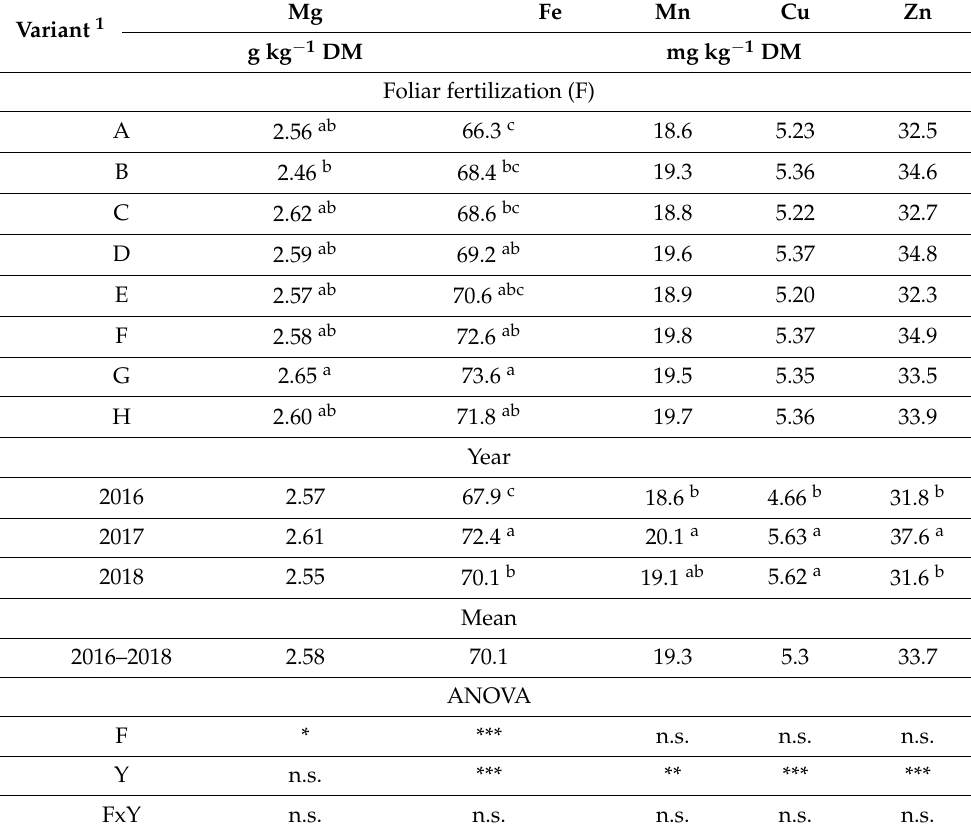
Table 5. The content of magnesium and selected microelements in seeds.